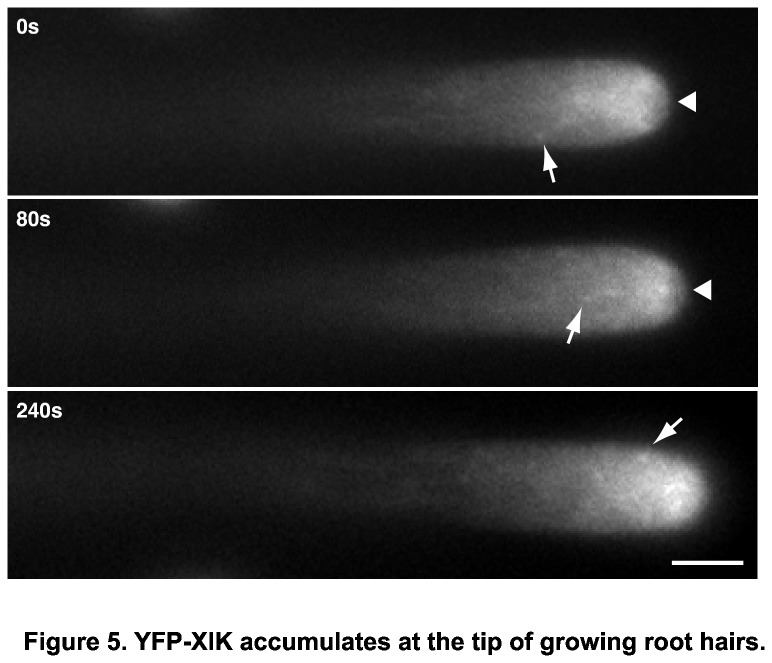
YFP-XIK accumulates at the tip of growing root hairs.Stable transgenic plants of XIKpro:YFP-XIK in xik-3 background showed maximal accumulation of YFP signal in the subapex of growing root hairs. Weaker accumulation occurred in the extreme tip (arrow heads). YFP-XIK labeled vesicles are difficult to distinguish at the tip while they are easier to detect in the shank of root hairs (arrows). Images are representative frames from a 30 minute time-lapse observation (see Movie S3). Size bar indicates 10 μm.